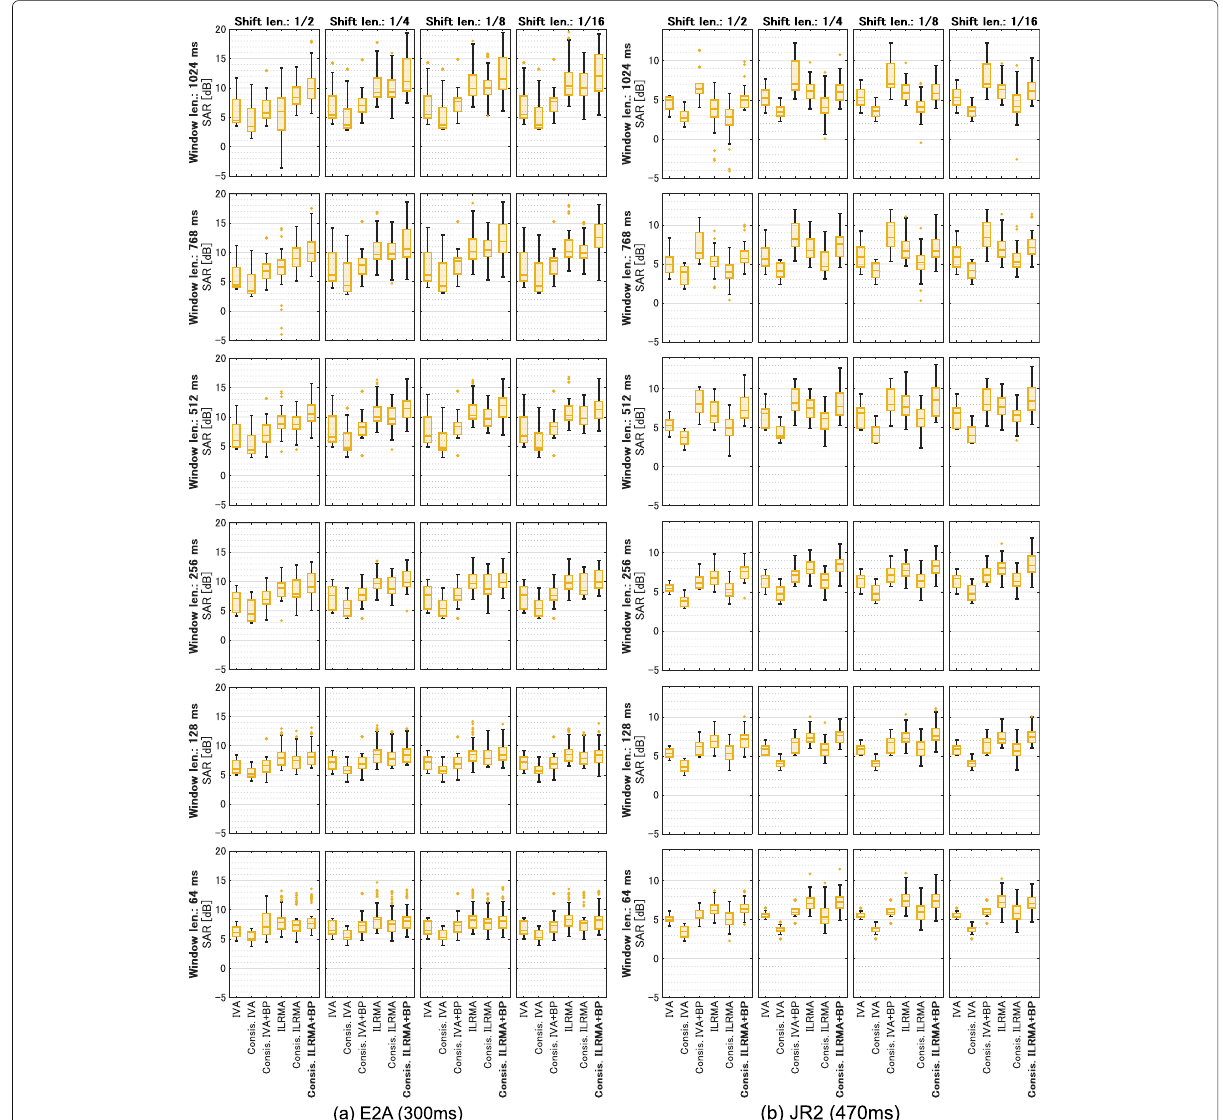
Fig. 25 Average SAR for synthesized speech mixtures (speech 1–10) with a E2A and b JR2 , where Hann window is used in